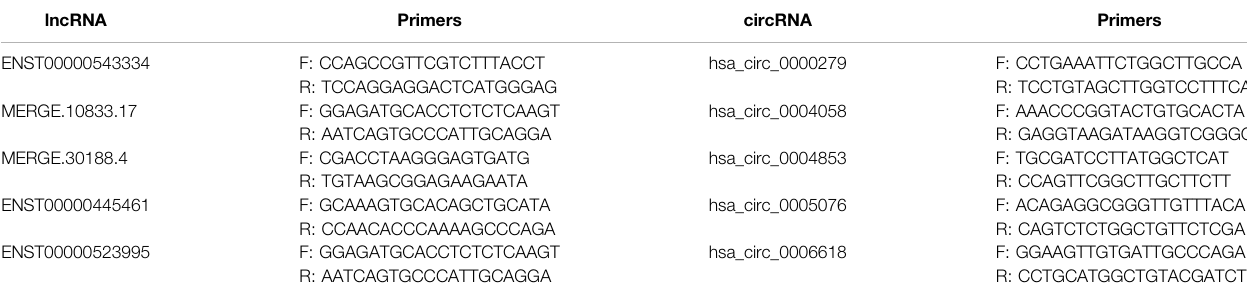
TABLE 5 | The sequences of the primers used in qRT-PCR experiments.